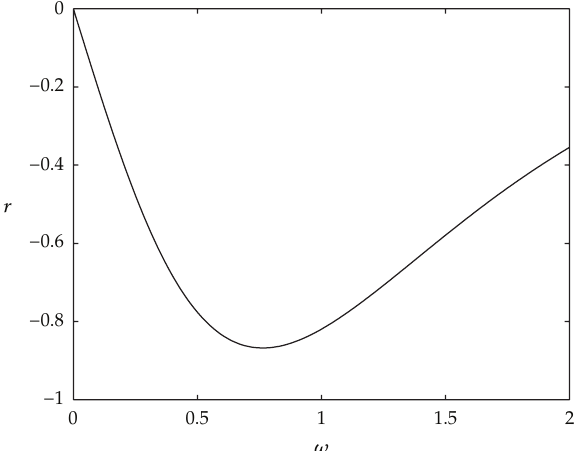
Figure 5: Homoclinic bifurcation curve for Smale horseshoe chaos in the (cid:6) ω,r (cid:7) plane for δ (cid:8) 0 . 5, F (cid:8) 1, (cid:8) 0 . 05, and δ (cid:8) 0 . 2. Above the curve transverse intersections of homoclinic orbits occur. D (cid:8) 1, δ 1 3